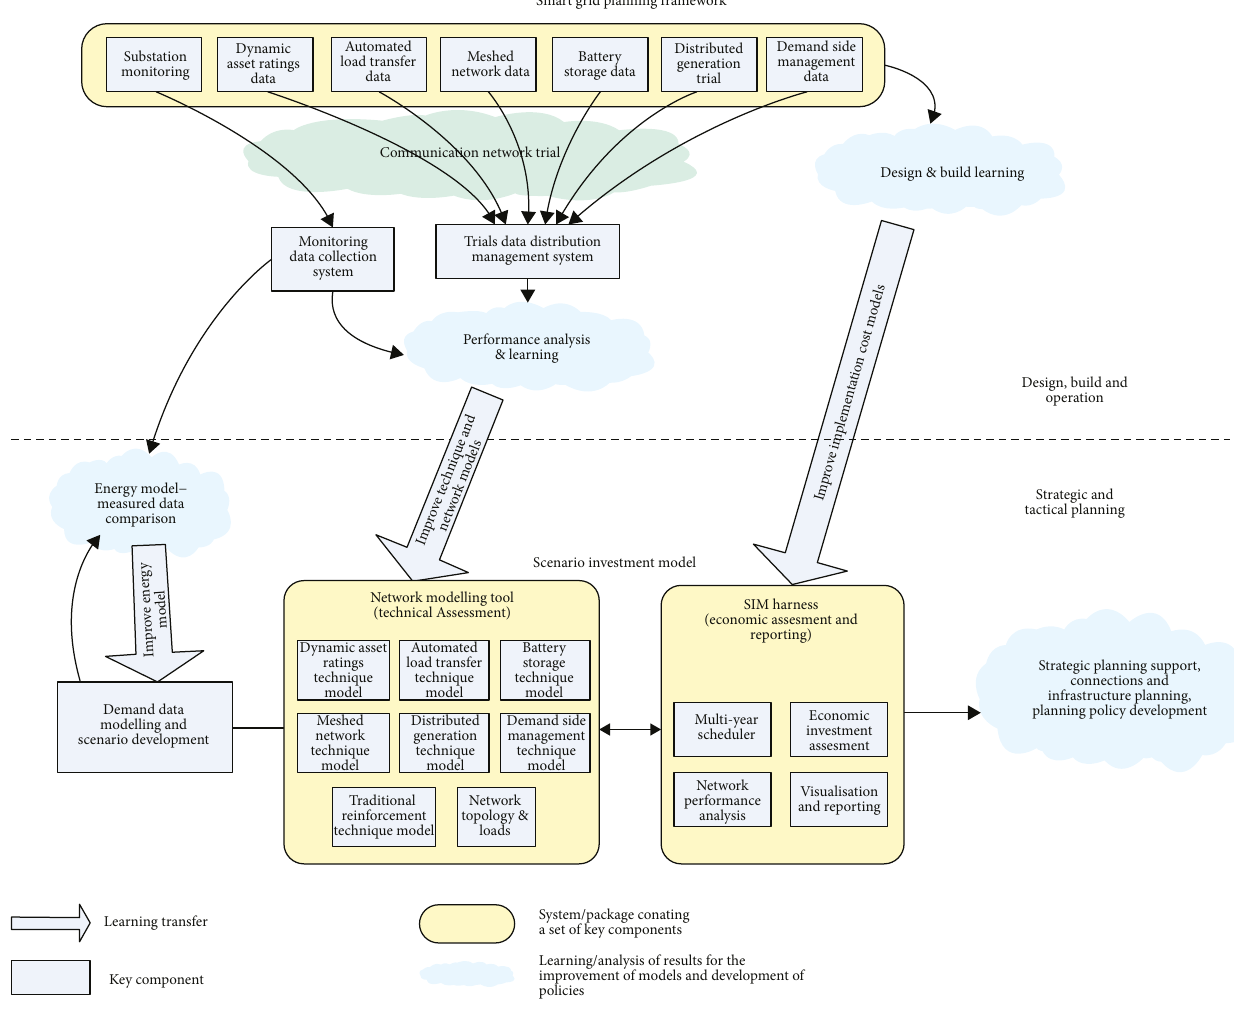
Figure 5: Smart grid planning framework